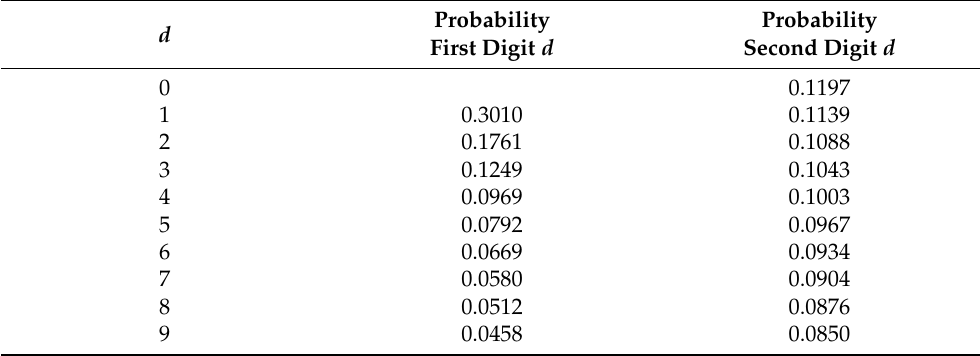
Table 1. Benford probabilities for first and second digit (to four decimal places).